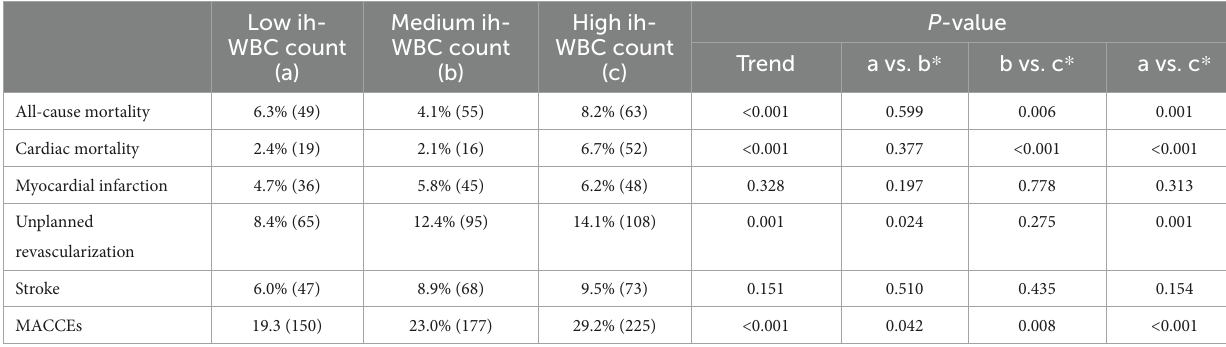
TABLE 3 Five-year cumulative incidence of adverse events.